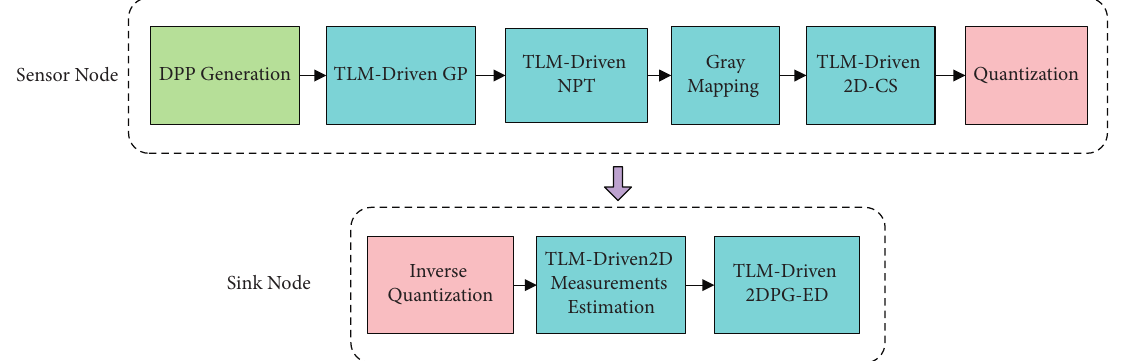
Figure 3: Secure image transmission between sensor nodes and sink nodes.